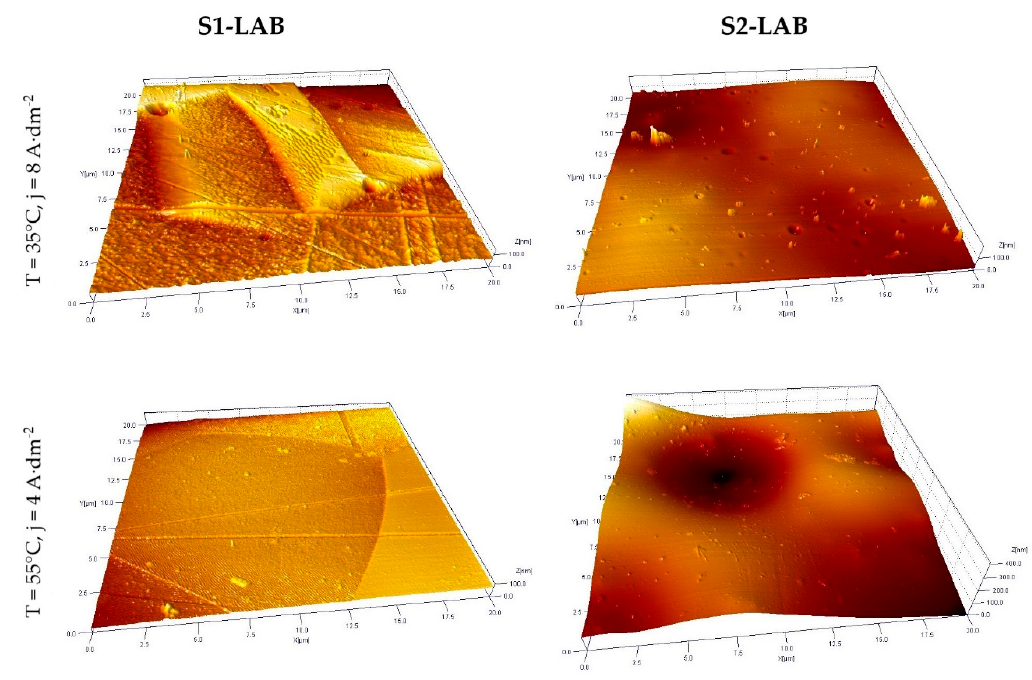
Figure 4. 3D images of the sample’s surface after the electropolishing acquired using AFM.